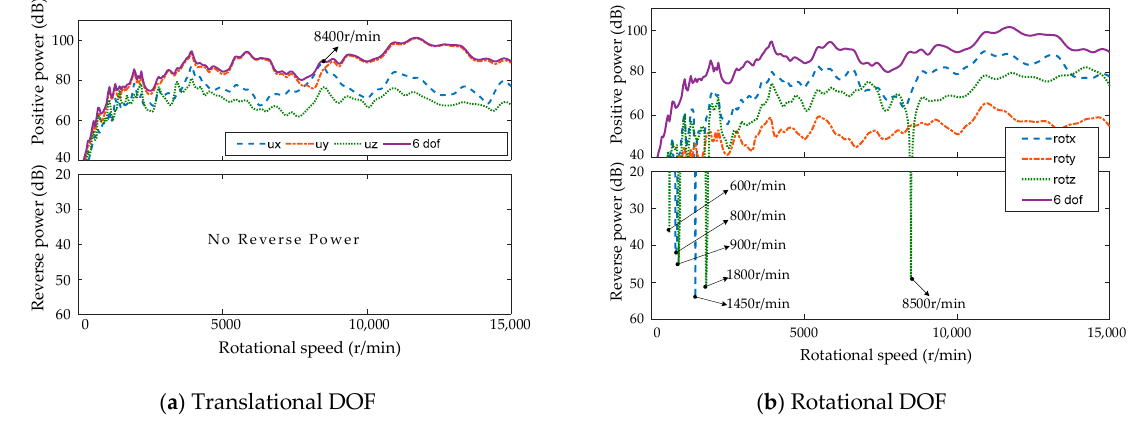
whole, the vibration power of the isolator is mainly in the vertical direction uy, and ux and uz also contribute to a certain extent at low speed. Ux has a resonance peak near 8400 r/min with an amplitude of 87.8 dB, which is 5.0 dB higher than the power of uy. Rotx has reverse power near 800 r/min and 1450 r/min, and rotz has reverse power near 600 r/min, 900 r/min, 1800 r/min, and 8500 r/min. However, these reverse powers are too small compared with the total power, and can be ignored.